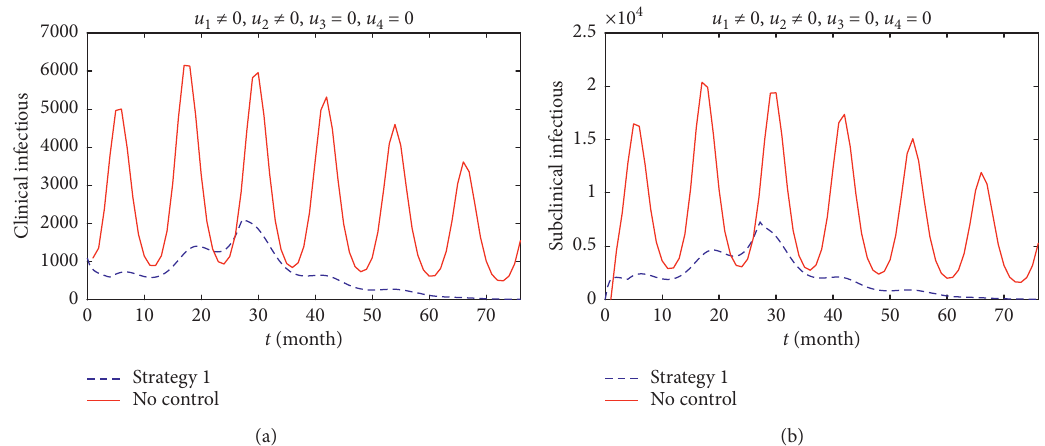
Figure 6: The time-series plots of I (a) and L (b) without (red line) and with (blue line) control Strategy 1.